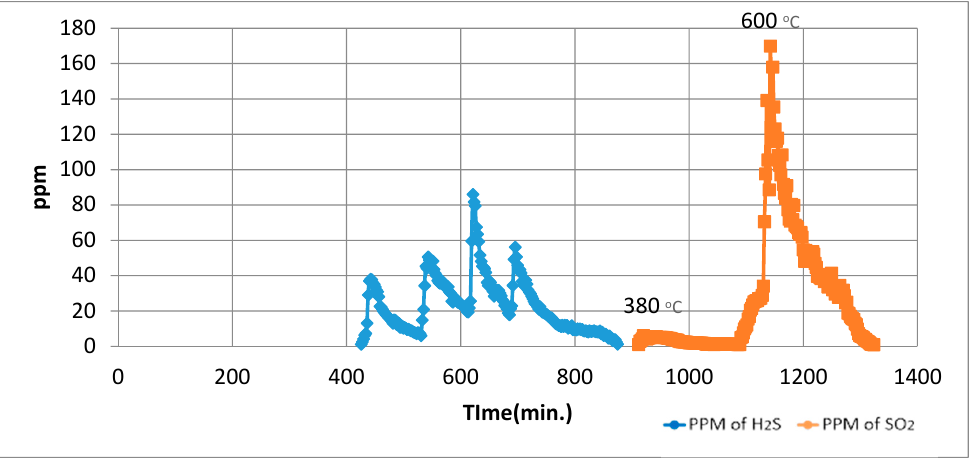
Figure 11. TPI of treated POW coal.